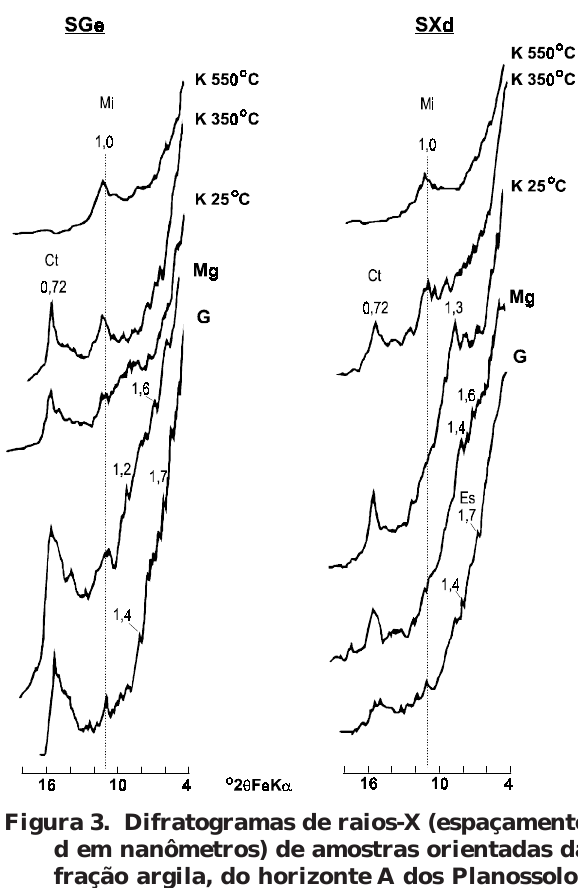
Figura 3. Difratogramas de raios-X (espaçamento d em nanômetros) de amostras orientadas da fração argila, do horizonte A dos Planossolos (SGe e SXd), saturadas por magnésio (Mg); solvatadas com glicerol (G), saturadas de potássio (K) e aquecidas até 550 °C. Mi = mica, Es = esmectita, Ct =